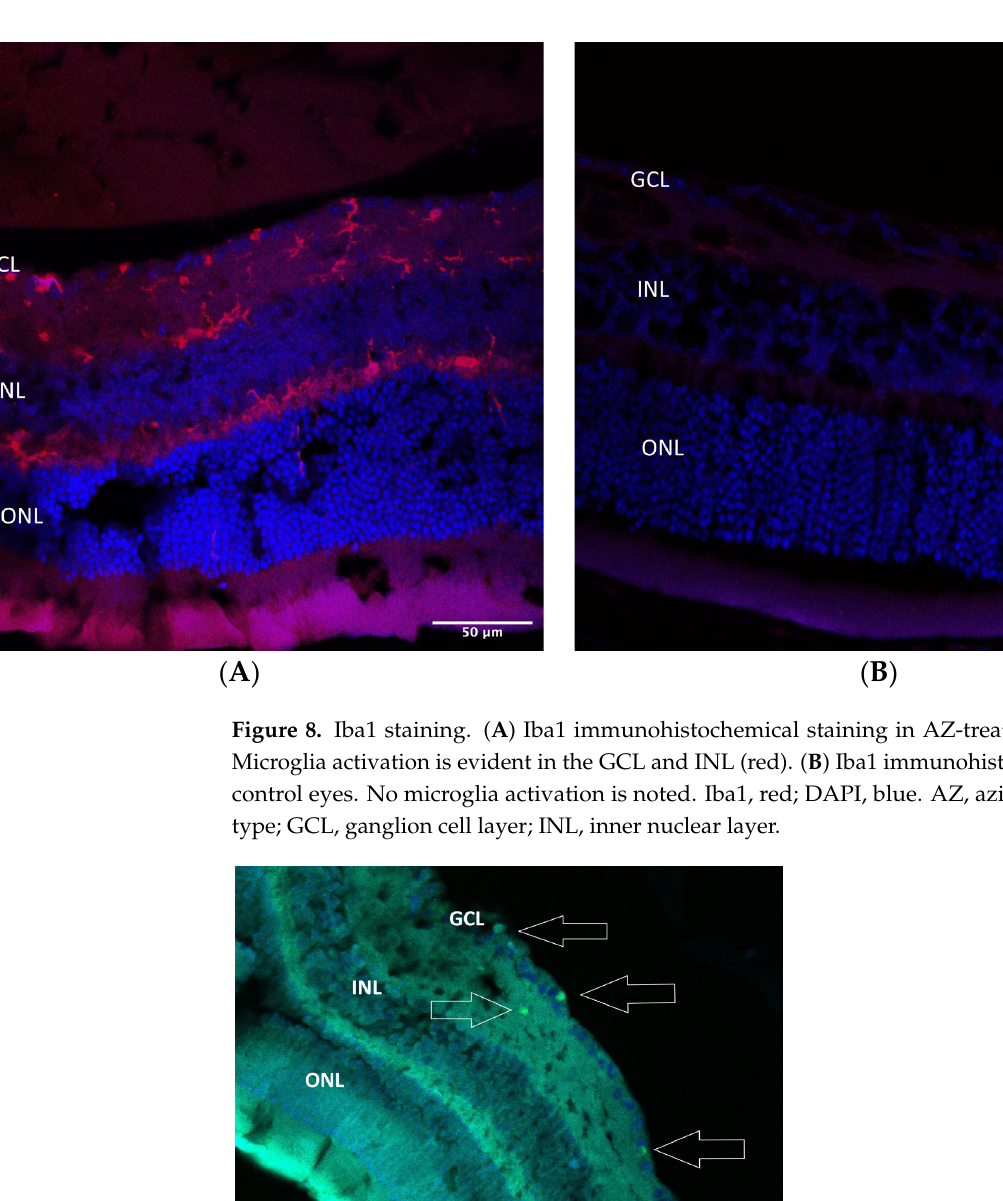
( F ) Figure 7. GFAP staining. ( A ) GFAP staining is positive (21.4 RFU) in the right eye of WT microbead-